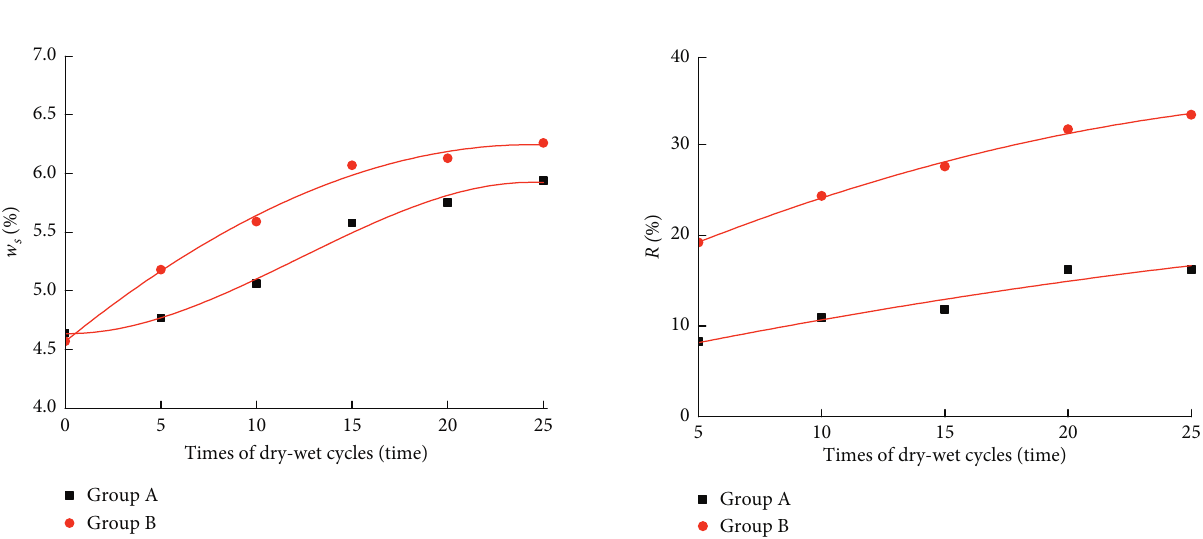
Figure 6: Longitudinal wave velocity change rates of the feldspar sandstones after a dry-wet cycle.